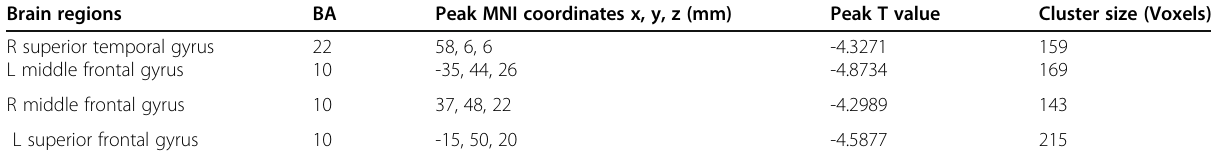
Thresholds were set at a corrected p <0.01 corrected by FWE